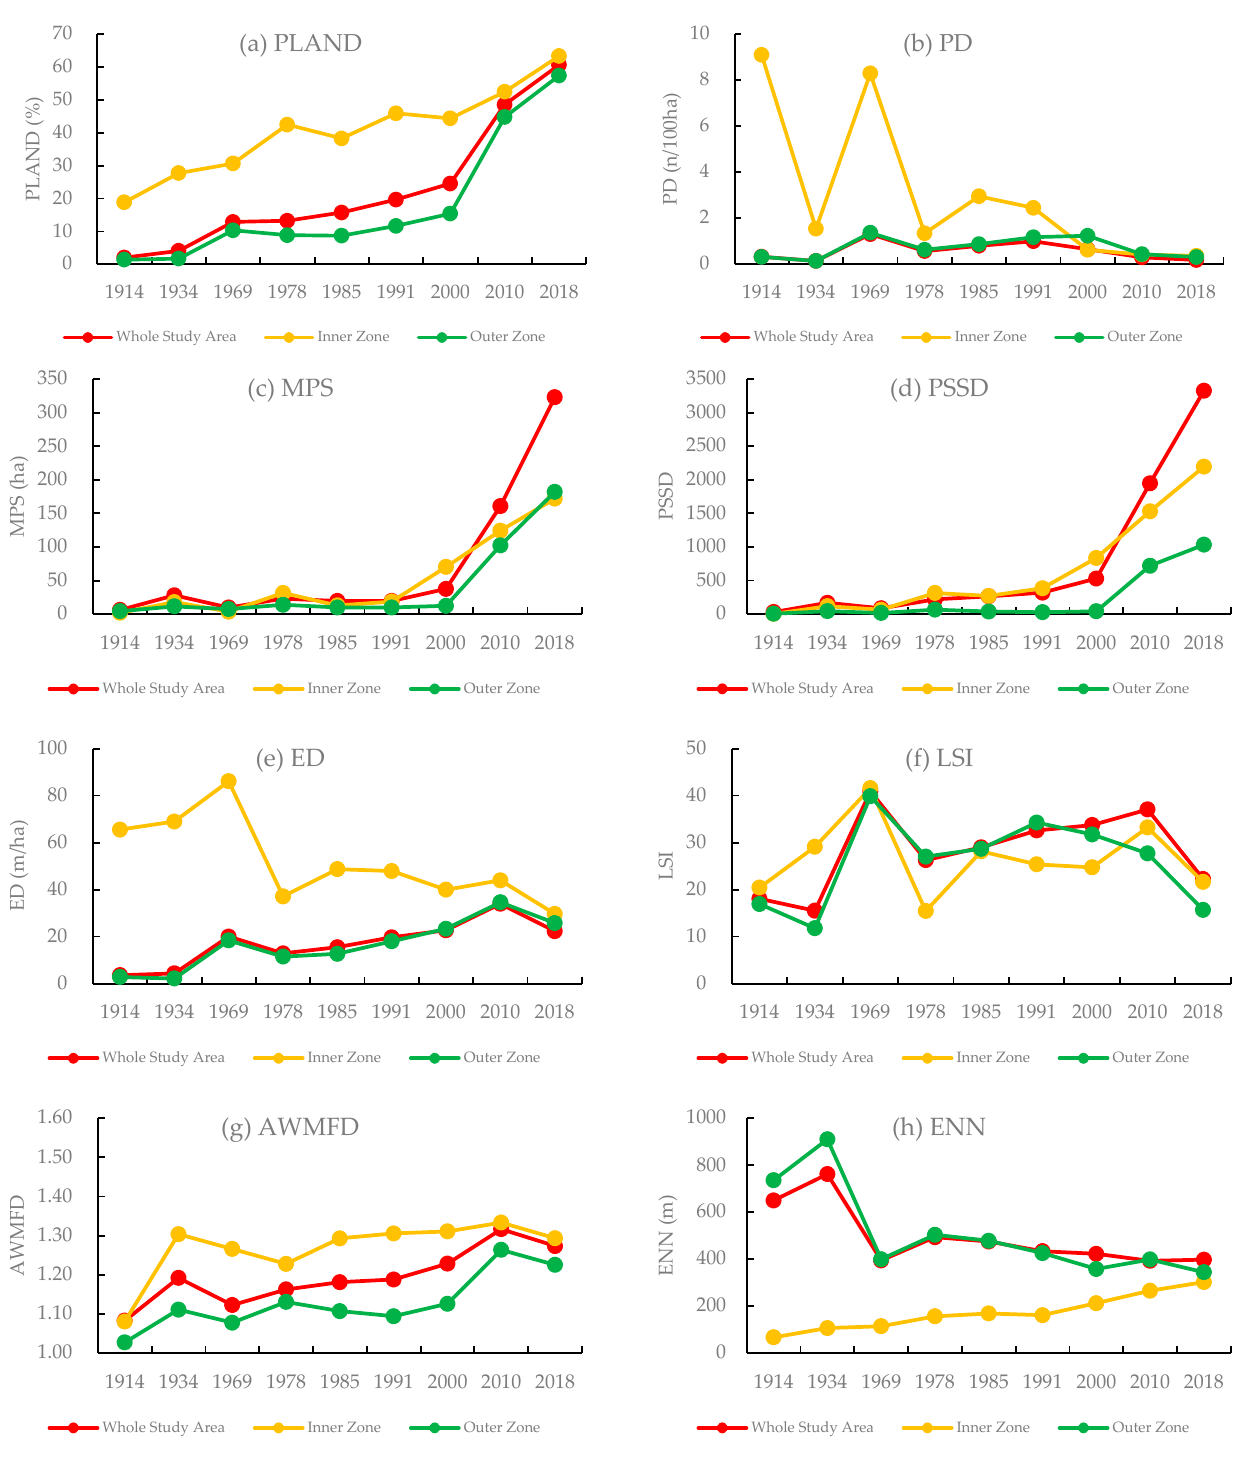
Figure 4. The changing trends of landscape metrics of urban built-up area in Hangzhou from 1914 to 2018: ( a ) percentage of landscape (PLAND); ( b ) patch density (PD); ( c ) mean patch size (MPS); ( d ) patch size standard deviation (PSSD); ( e ) edge density (ED); ( f ) landscape shape index (LSI); ( g ) area-weighted mean fractal dimension (AWMFD); ( h ) mean Euclidean nearest neighbor distance (ENN).